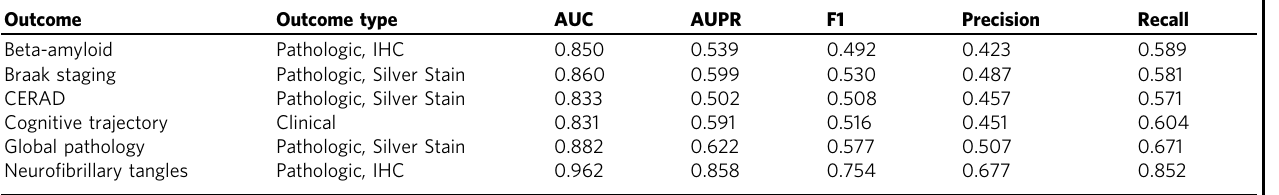
The performance evaluation is on independent testing set on 450K array. The result reported here is in imbalanced setting (positive to negative CpGs ratio 1:10), which is closer to the real imbalanced setting in the human